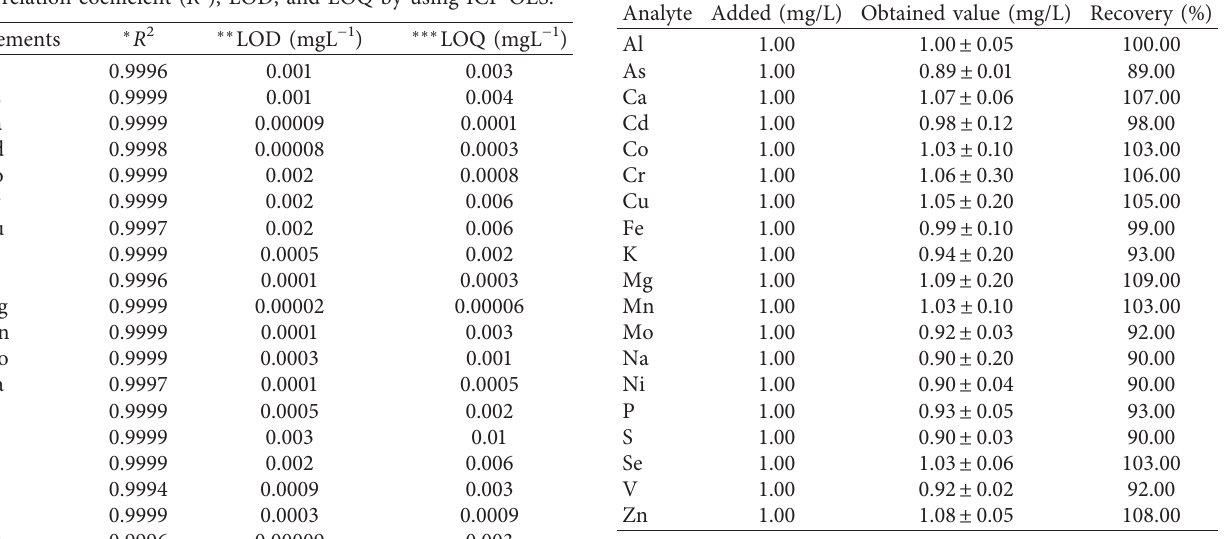
Table 3: Parameters of calibration obtained external calibration: correlation coefficient ( R 2 ), LOD, and LOQ by using ICP OES.